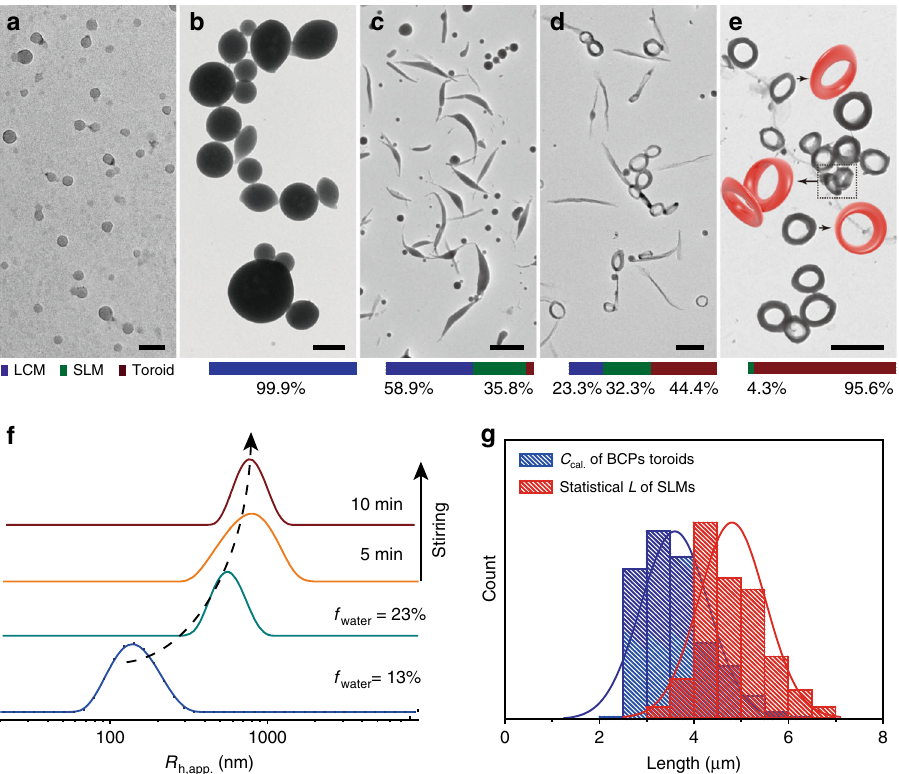
Fig. 2 Morphological evolution during the self-assembly of PS- b -PDLA into toroidal micelles. TEM images of the intermediate assemblies obtained at varied water content (volume fraction, f water ): a 13%, b 18%, c 23%. d , e Assemblies achieved after 5 and 10 min upon adding water, respectively. Frequency bar charts of the assembled morphologies (LCMs, SLMs, and toroids) at given water content and varied time duration, statistic more than 300 particles. f R h,app. distributions of the assemblies in solution depending on time duration. g Length of the spindles ( L ) (Fig. 2c) and calculated perimeter ( C cal. ) of the